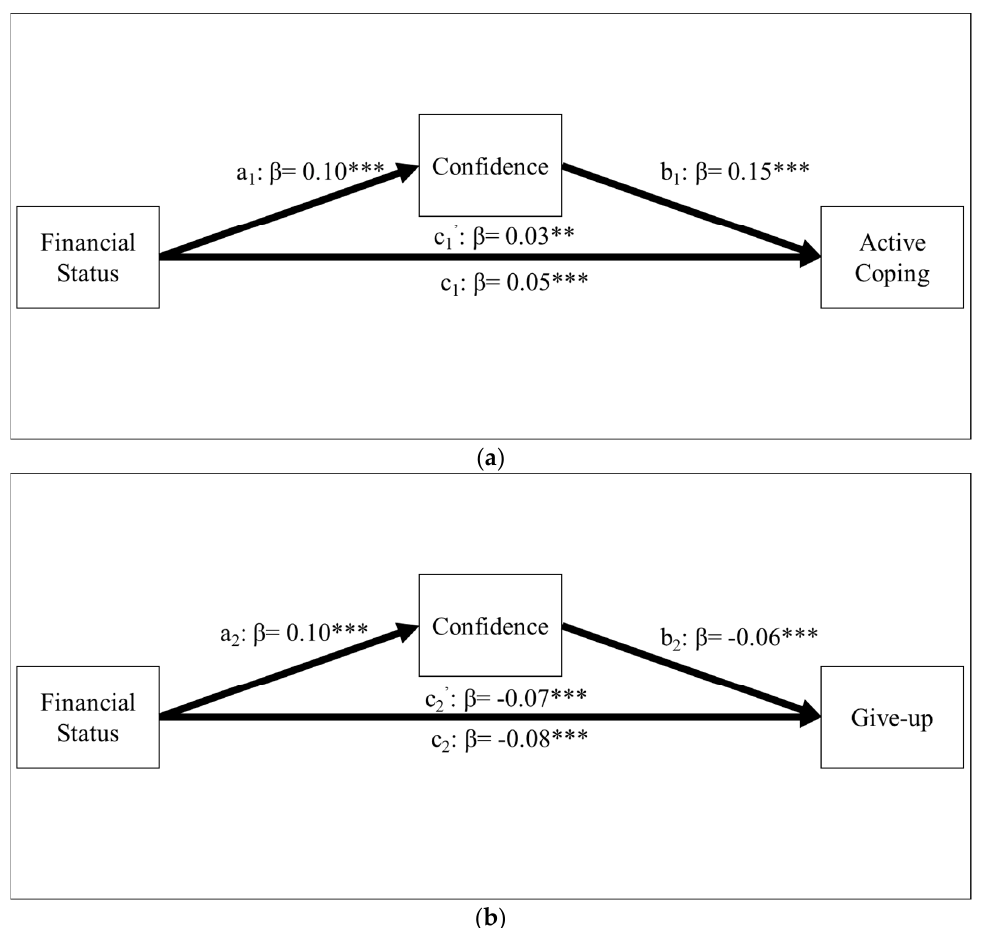
Figure 1. ( a ) Confidence in coping abilities mediates the relationship between financial status and active coping (model 1). ( b ) Confidence in coping abilities mediates the relationship between financial status and giving-up tendencies (model 2). ** p < 0.01. *** p < 0.001.